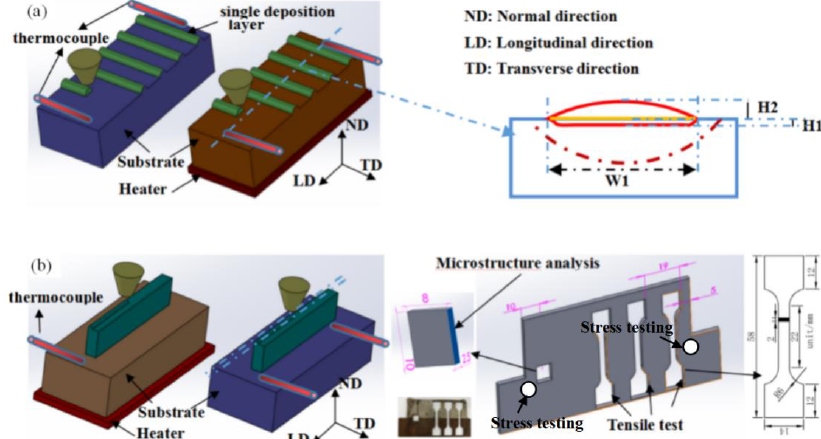
Figure 1. The schematic drawing of the single deposition layer on the substrate and method for selecting geometrical characterization specimens: ( a ) thin wall deposition layers on the substrate; ( b ) method for selecting microstructure and mechanical properties